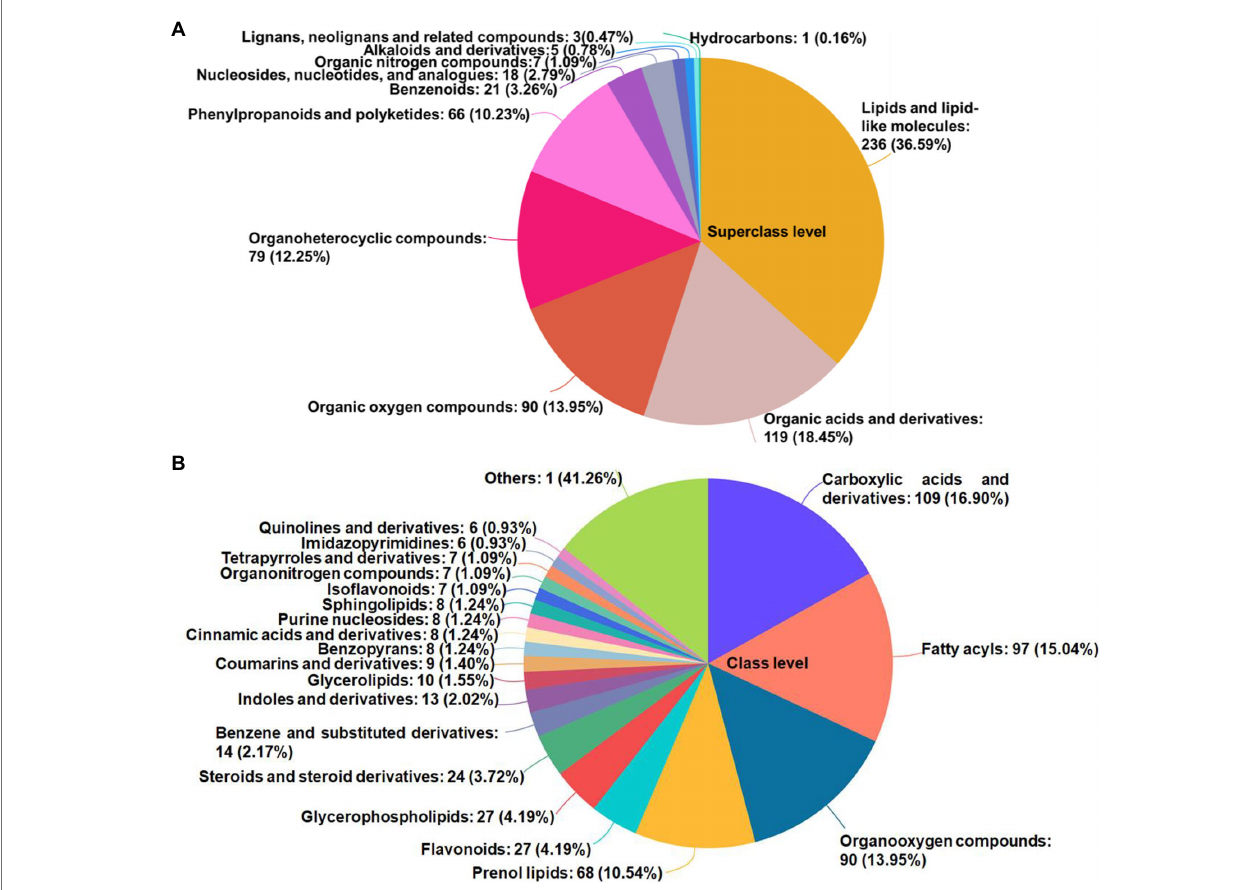
FIGURE 3 | The HMDB compound classification of identified metabolites. The names of the HMDB superclass (A) and class (B) levels and the percentage of metabolites in order of the number of metabolites were shown. The different colors represented different HMDB classifications, and the area represented the relative proportion of metabolites in this classification. HMDB, human metabolome